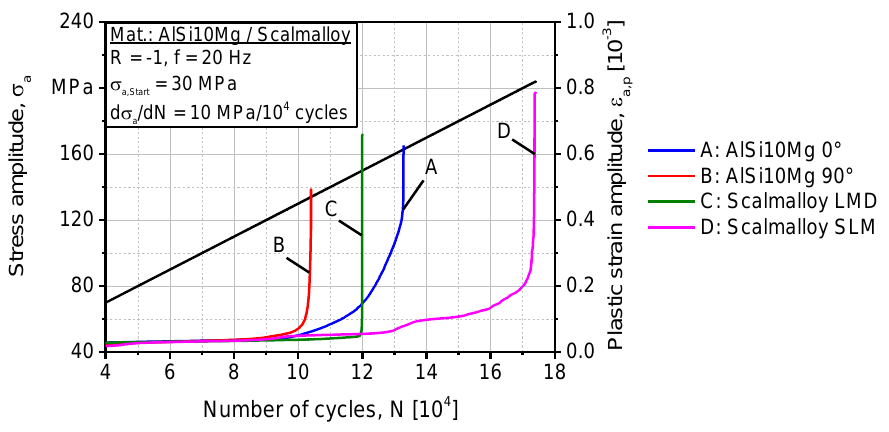
Figure 12. Plastic strain response of batches A–D in a load increase test that is used as input to the finite-element (FE) simulation.